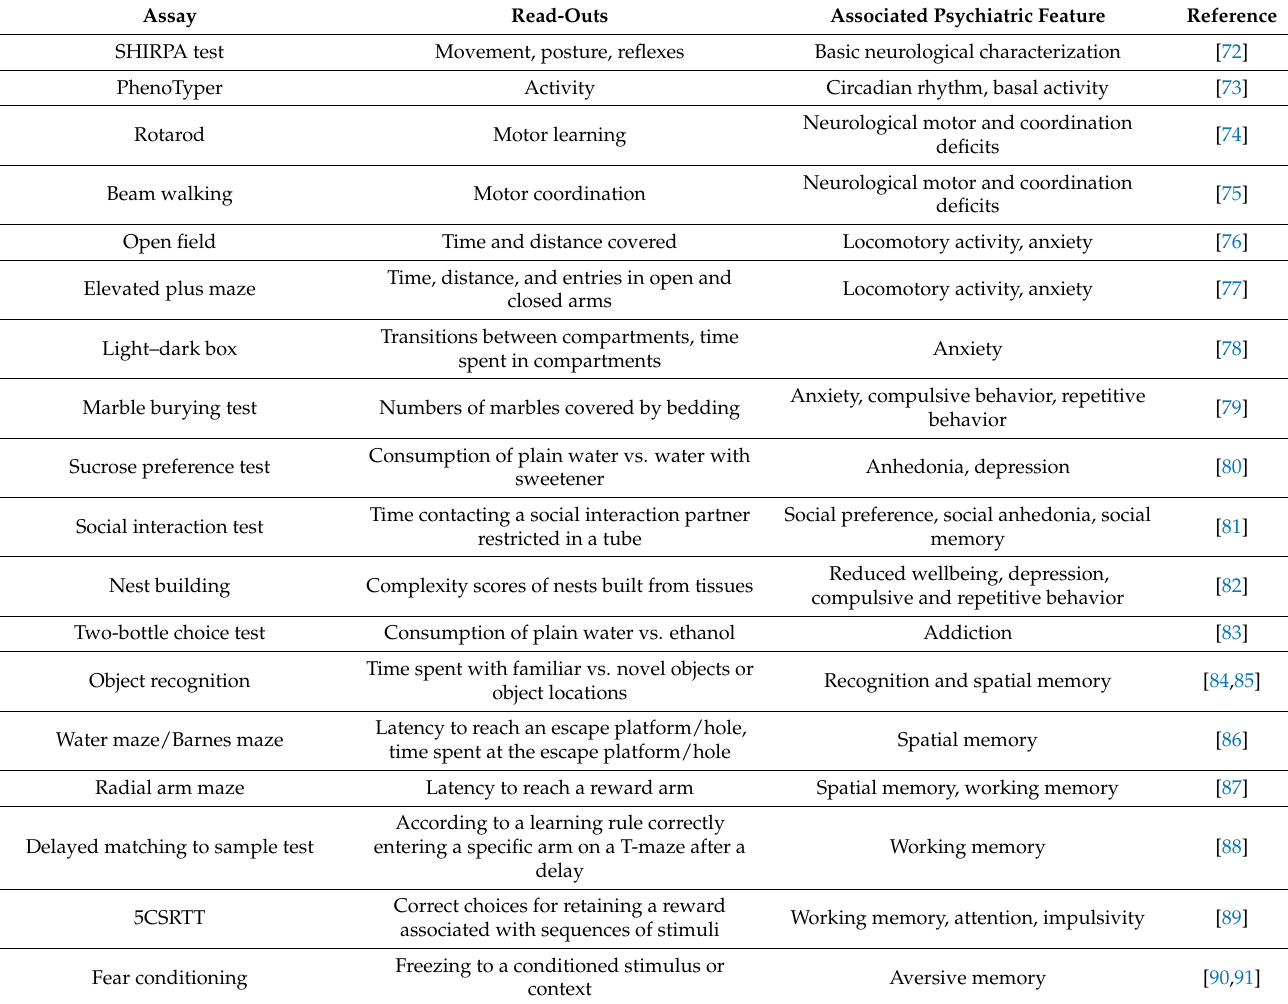
Table 3. Behavioral assays for neuropsychiatric features in